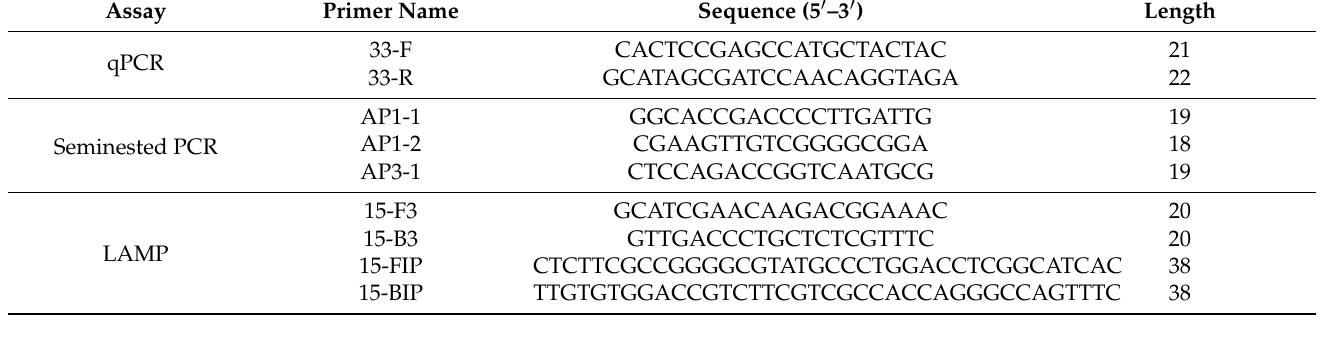
Table 2. Primer sequences of seminested PCR, qPCR, and LAMP for A. phaeospermum detection.